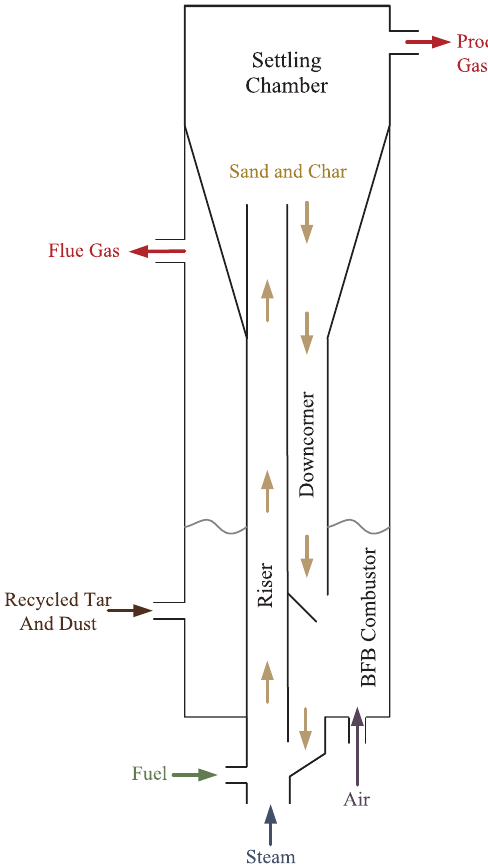
Fig. 4 Lab-scale MILENA gasifier. Source: Adapted from Van der Meijden et al. (2010)